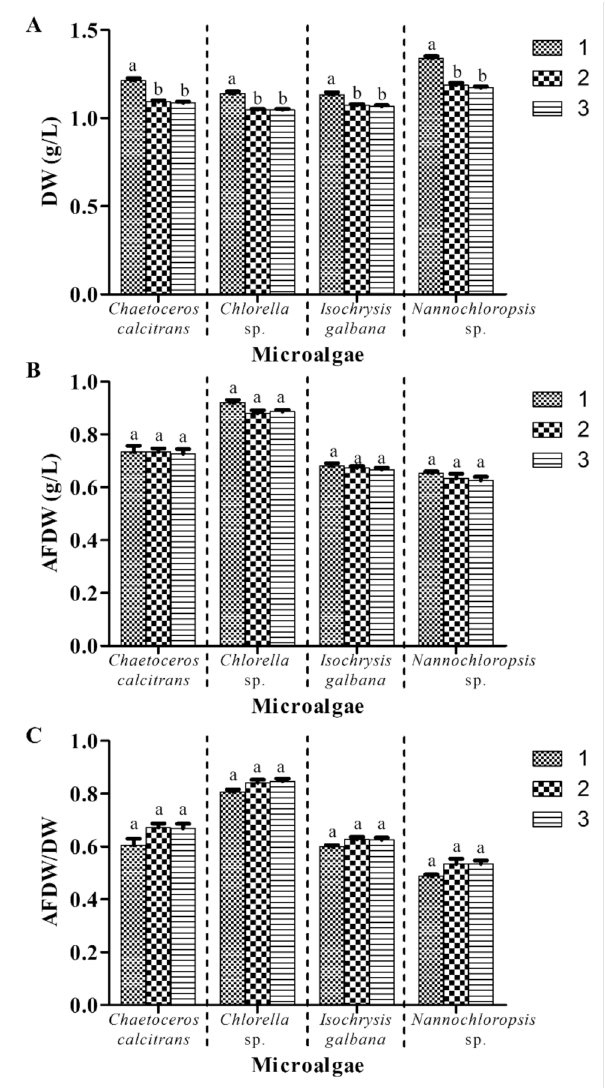
Figure 7. Biomass of four different marine microalgae subjected to a different number of washing cycles. ( A ) dry weight ( B ) ash-free dry weight ( C ) ash-free dry weight/dry weight. The other parameters remained constant (with washing process; GF/A; pretreatment of GMF at 450 ◦ C for 2 h; 0.05 M ammonium formate; 1:2 culture: washing agent ratio). Different letters for the respective microalgae indicate statistically significant differences ( p < 0.05) in terms of dry weight among different washing cycles. DW, dry weight; AFDW, ash-free dry weight. Data are expressed as mean ± standard error (n =